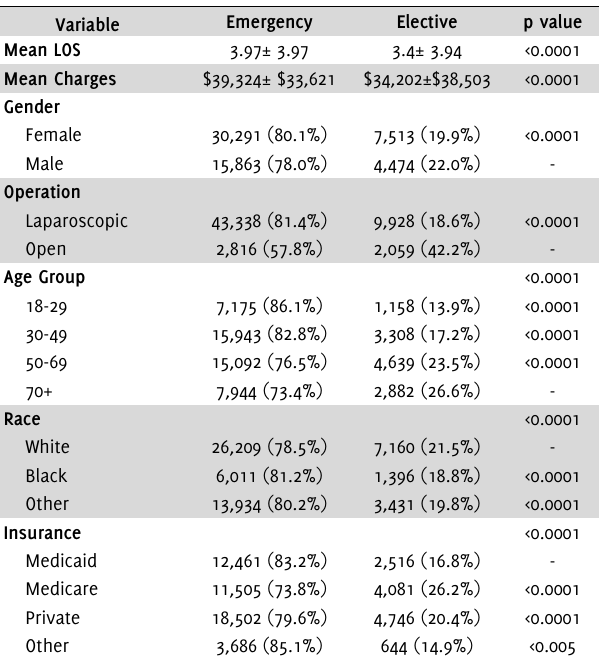
Table 3. Cholecystectomy Patient Characteristics By Clinical Presentation (2013-2016)